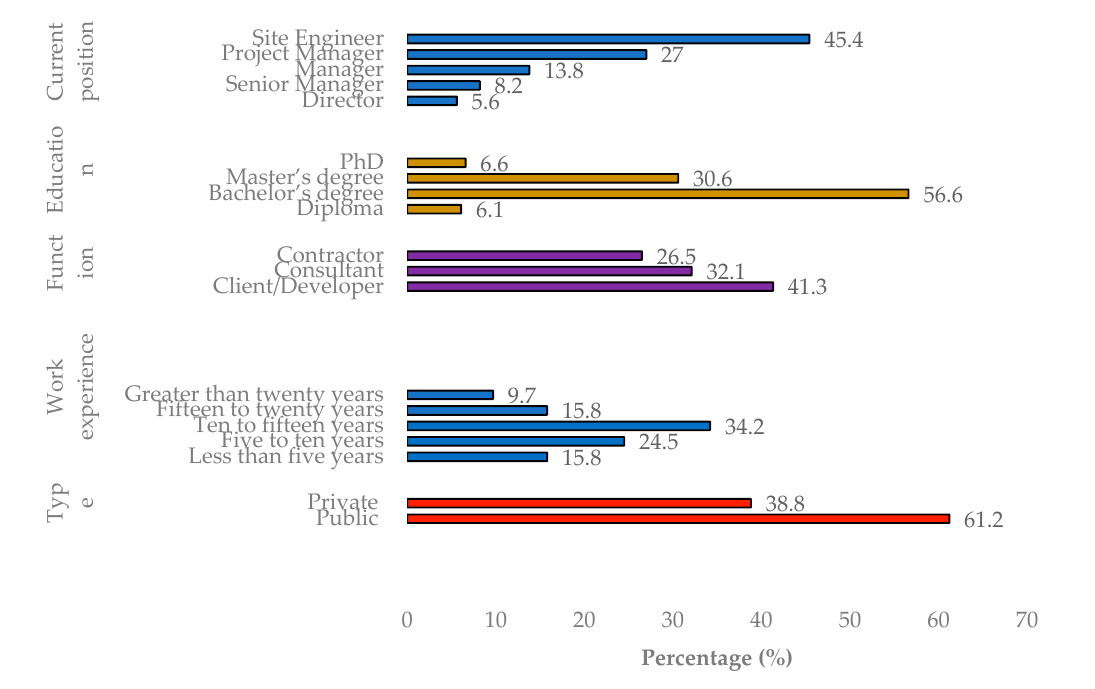
Figure 2. Respondent background rate. Table 3. The demographic characteristics.